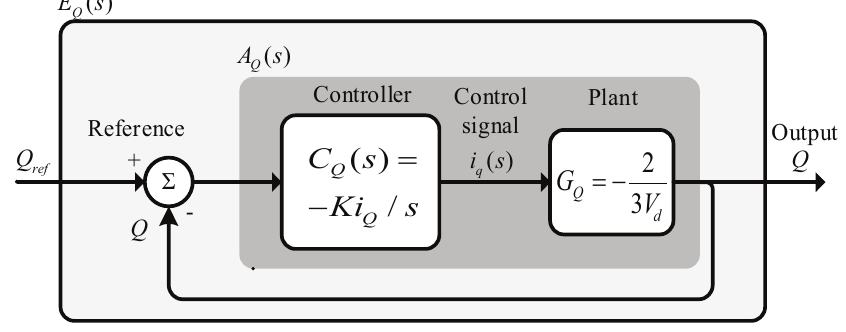
Figure 10. Schematic diagram for the reactive power control